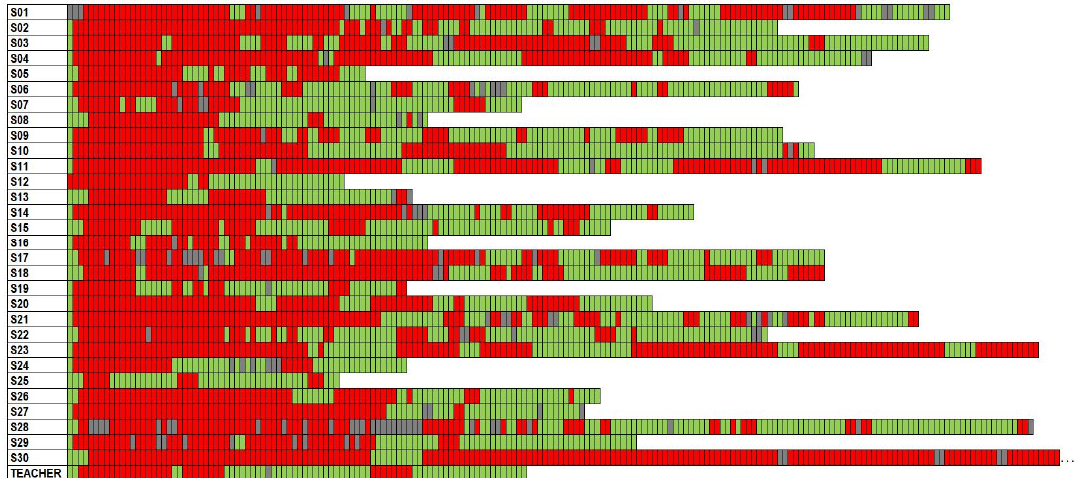
Figure 10. Sequence chart for Task07 showing the distribution of participants’ fixations on the map field (green) and legend (red). Grey represents fixations out of the AOI.